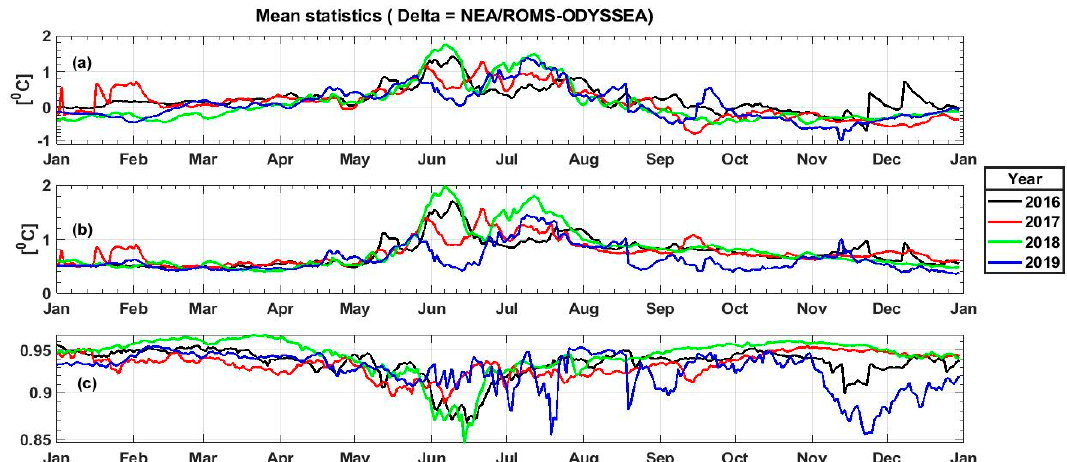
Figure 3. Temporal evolution of the mean Sea Surface Temperature (SST) basin averaged statistics for the (NEA_ROMS Model-ODYSSEA satellite data) in °C for the model simulation period from 1st January 2016 until 31st December 2019. ( a ) Bias, ( b ) root mean square error (RMSE), ( c ) correlation coefficient, the critical correlation R = 0.1 at 95% confidence limit. The continuous black, red, green, and blue lines present the years 2016, 2017, 2018, and 2019, respectively.